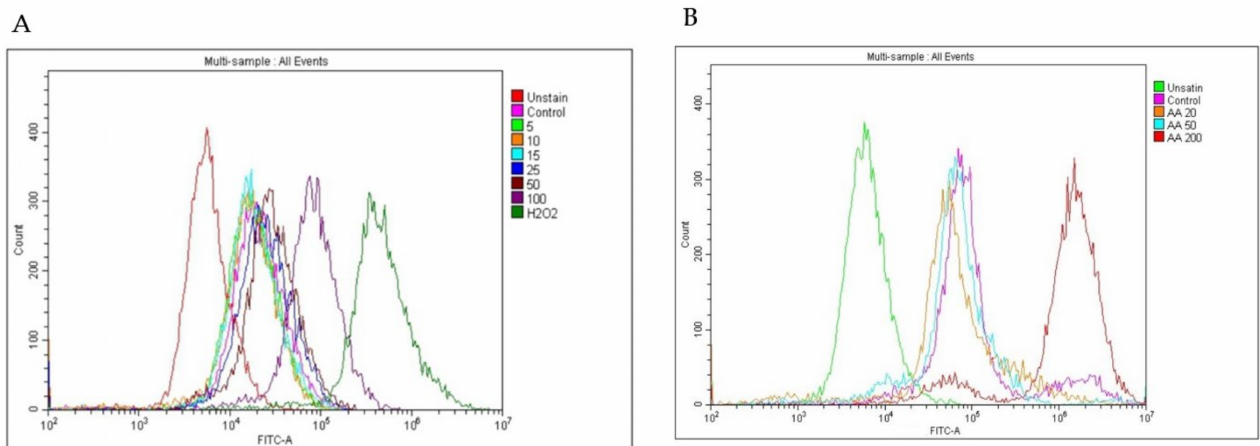
Figure 5. HCT-116 cells were treated with PPE (5–100 µ g/mL) and H 2 O 2 (500 µ M) for 6 h and AA (20 µ g/mL, 50 µ g/mL, and 200 µ g/mL) for 24 h. The cells were incubated with H 2 DCFDA for 30 min at 37 ◦ C, and the fluorescent intensity was measured with a flow cytometer (BD Canto II). ( A ) DCF intensity of HCT-116 treated with PPE (5–100 µ g/mL) and H 2 O 2 (500 µ M); ( B ) DCF intensity of HCT-116 treated with AA (20 µ g/mL, 50 µ g/mL, and 200 µ